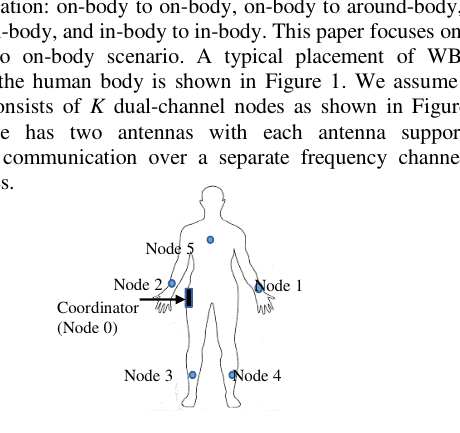
Figure 1: WBAN on a human